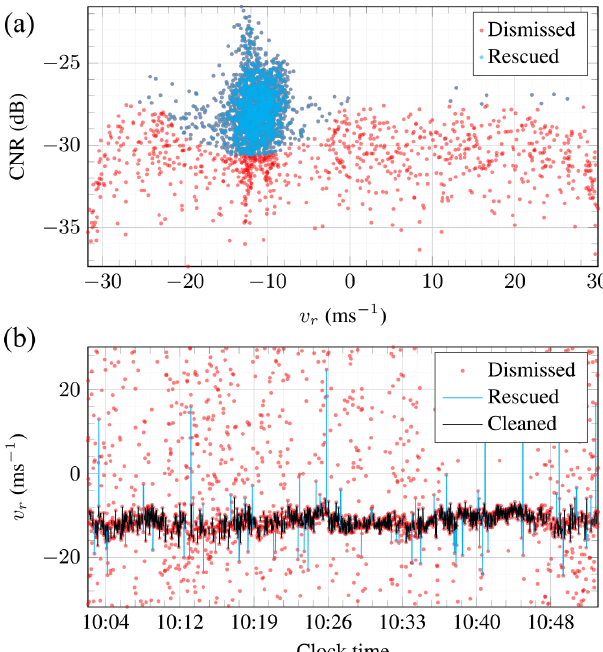
Figure 6. (a) Scatter plot of the CNR versus the along-beam ve- locity on 25 October 2019 from 10:03 to 10:52 for the range gate located 275m away from the lidars. (b) Corresponding time series showing the dismissed and rescued samples using the Mahalanobis distance and the cleaned data after application of outlier analysis based on the median absolute